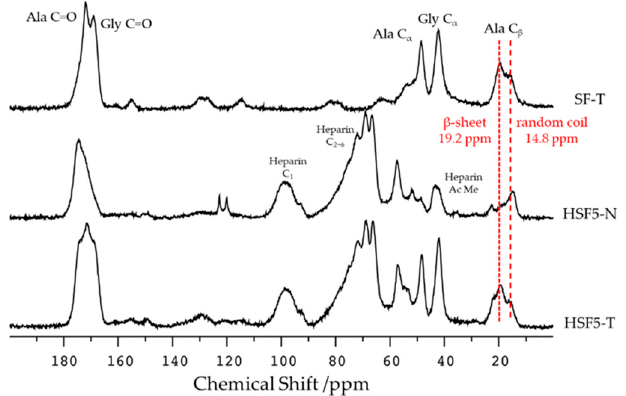
Figure 3. 13 C CP/MAS NMR spectra of film samples of SF-T, HSF5-N, and HSF5-T films (T: after insolubilized, and N: before insolubilized). Peak intensities were normalized by SF glycine C α .